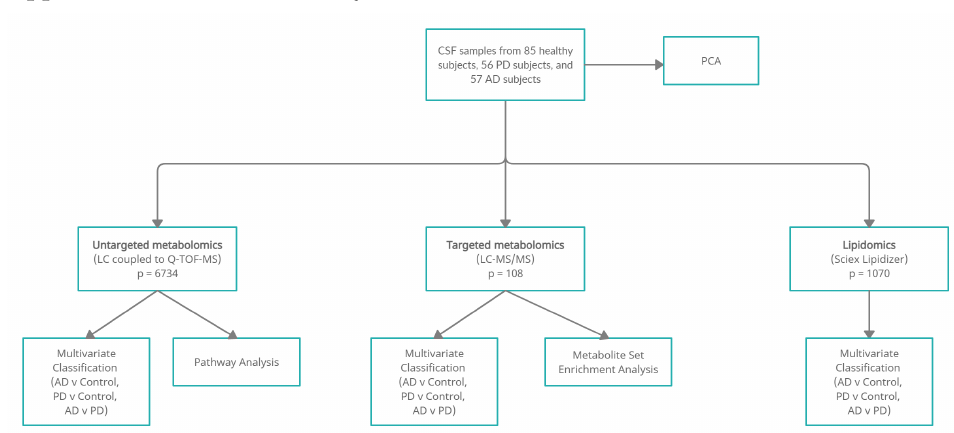
Figure A2. Flowchart outlining the analysis performed on each of the three profiles.